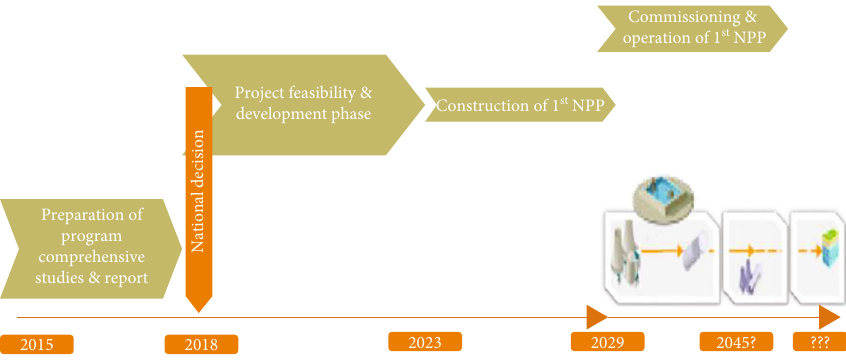
Figure 4: Ghana nuclear power programme